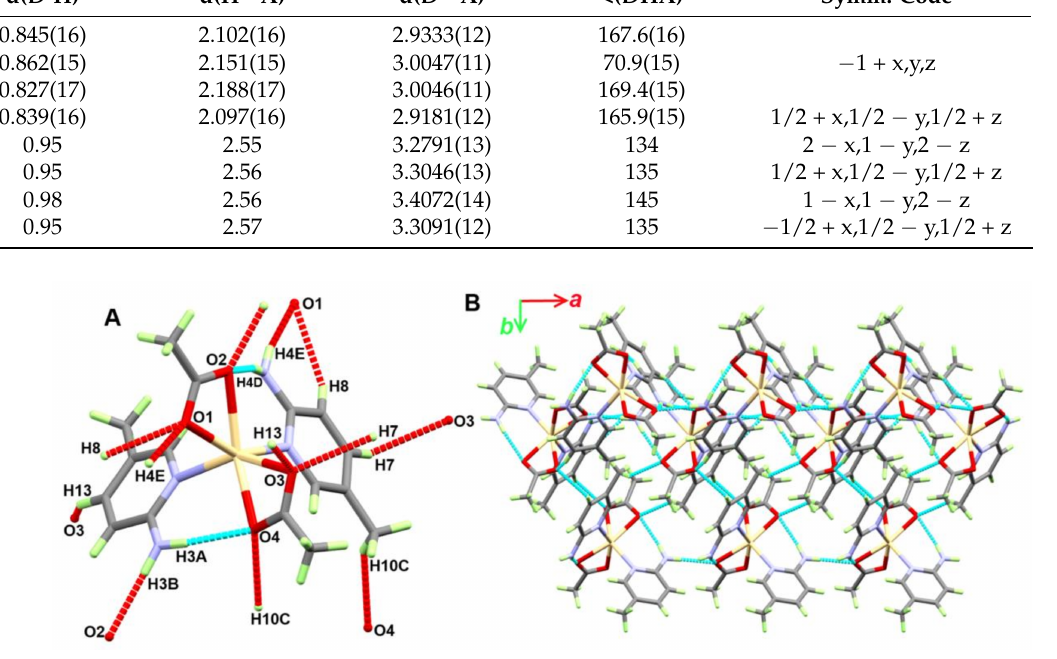
Figure 7. The intra- and intermolecular contacts ( A ) and packing scheme via O-H ··· O hydrogen bonds along a b plane ( B ) of 3 .